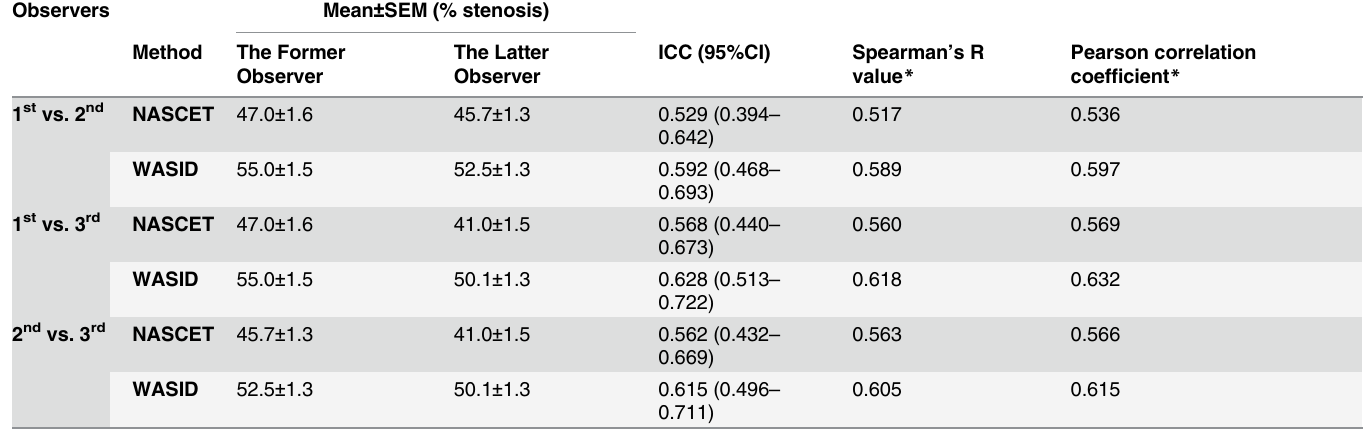
Table 5. Mean ± SEM, ICC, Spearman ’ s R value, and Pearson correlation coefficient statistics of inter-observer agreement.